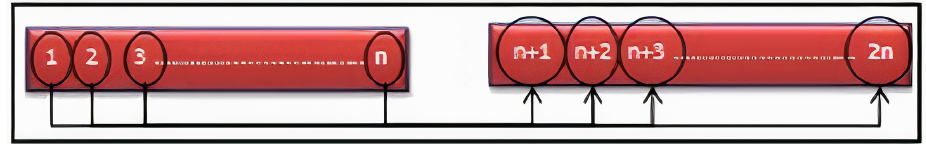
Figure 2. Representation of the virtual customers ( n + 1,...,2 n ) .